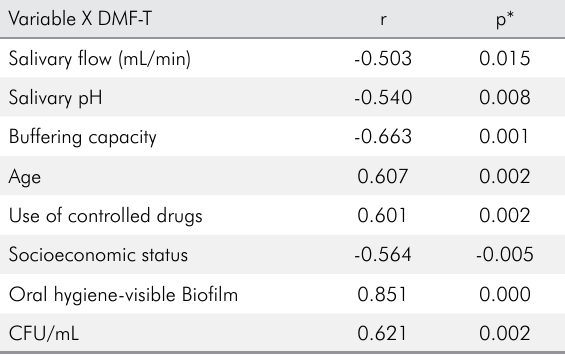
*Statistically significant difference (p < 0.05).